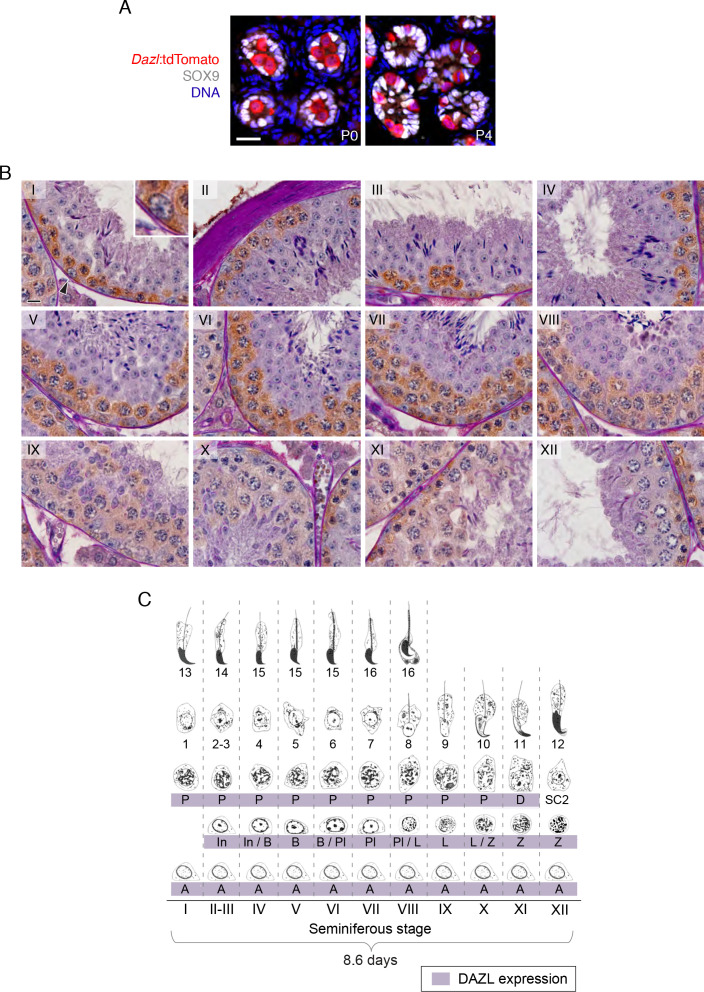
DAZL expression in postnatal gonocytes and during spermatogenesis.(A) Male gonocytes at postnatal days (P) 0 and 4 express the Dazl:tdTomato reporter. SOX9 marks Sertoli cells. Scale bar = 20 μm. (B) DAZL immunohistochemistry in adult testis. DAZL localized to type A, intermediate, and type B spermatogonia as well as spermatocytes from the preleptotene through diplotene stages. Roman numeral designates stage of the primary tubule in each panel. Type A spermatogonium highlighted by arrowhead in stage I tubule is enlarged within inset. Scale bar = 10 μm. (C) Summary of DAZL expression by stage of spermatogenesis, based on immunohistochemistry in B. Abbreviations, in spermatogenic order: A, type A spermatogonium; In, intermediate spermatogonium; B, type B spermatogonium; Pl, preleptotene spermatocyte; L, leptotene spermatocyte; Z, zygotene spermatocyte; D, diplotene spermatocyte; SC2, secondary spermatocytes. The numbers indicate the ‘step’ staging designation of the corresponding spermatids.